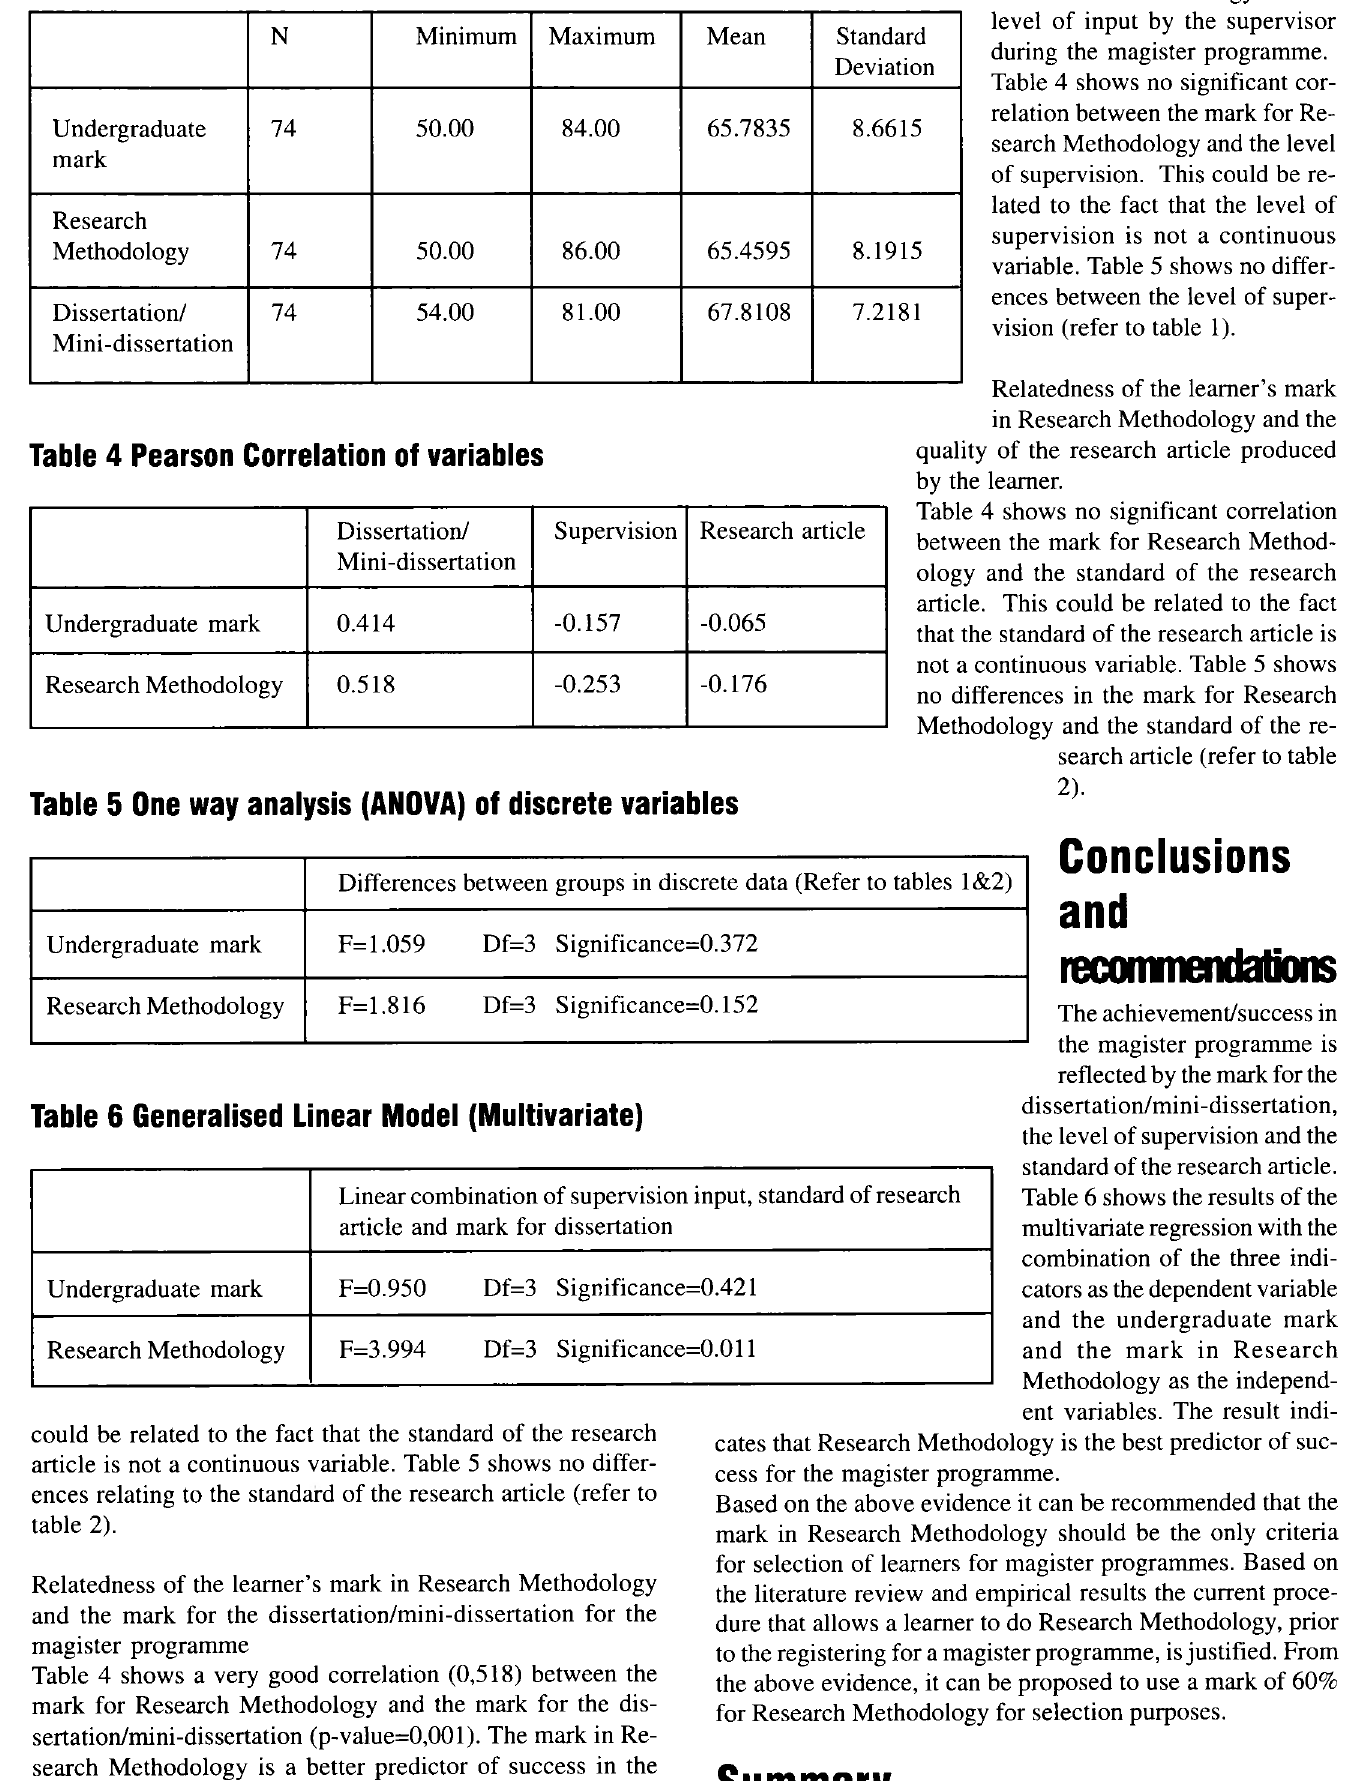
Table 4 Pearson Correlation of variables